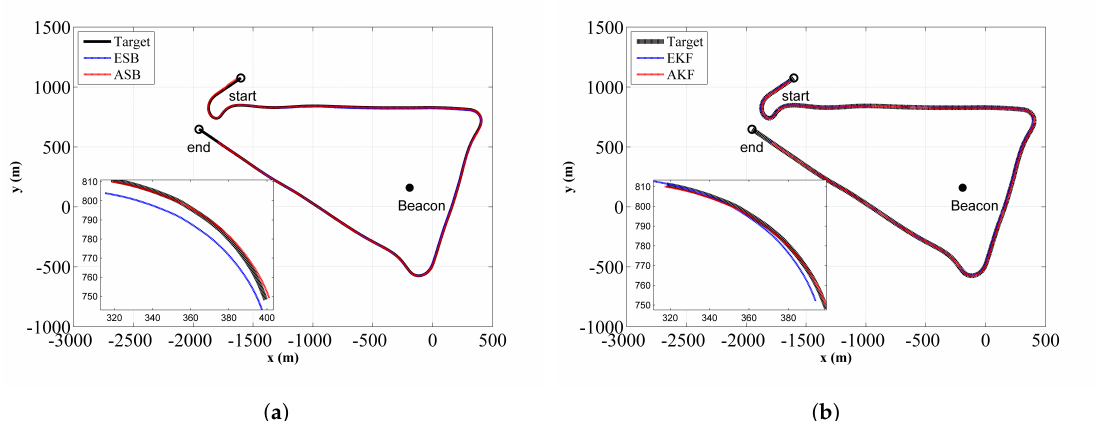
Figure 11. Planar position estimates comparison between the ESB and the ASB algorithms using field data with unknown Q k : ( a ) Filter; ( b ) RTS